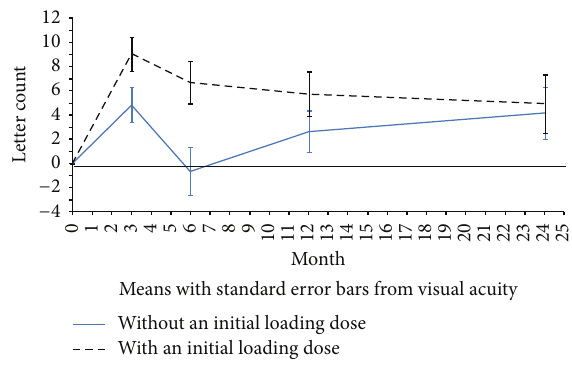
Figure 1: Changes in visual acuity over the follow-up period compared with visual acuity at baseline.